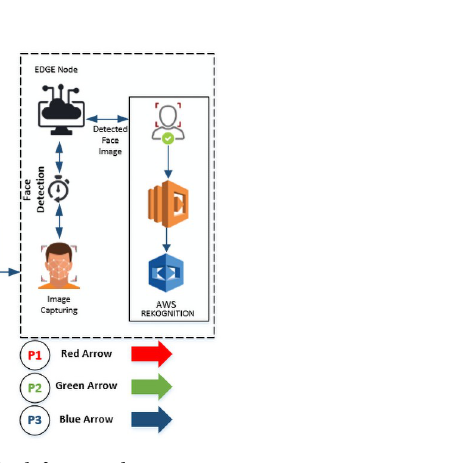
Fig 3. Work flow of the proposed Consumer-Auth